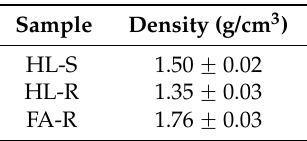
Table 7. Density of the dense pastes HL-S, HL-R and FA-R pastes.